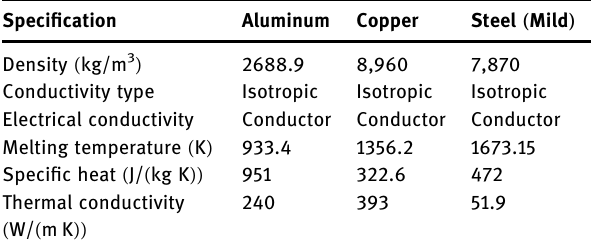
Table 1: Material speci fi